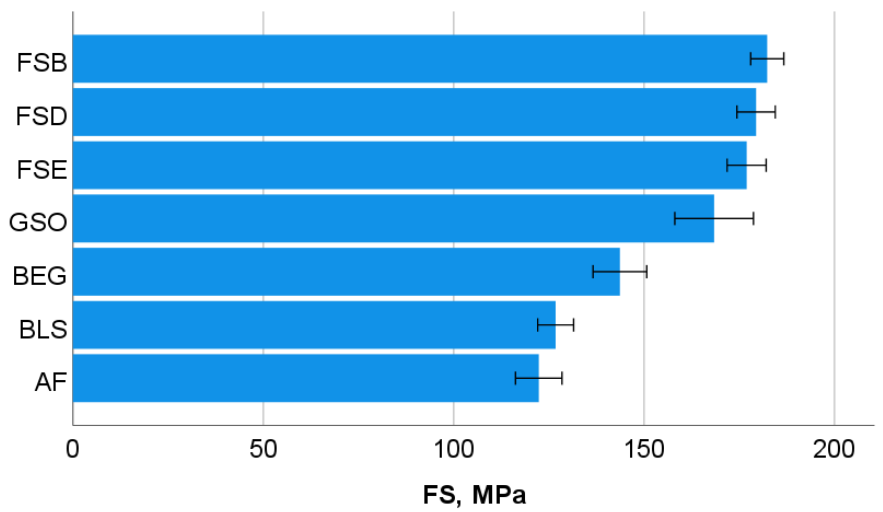
Figure 2. Three-point bending test: flexural strength (FS) with mean values and 95% confidence interval. Material abbreviation: AF = Admira Fusion; BEG = Brilliant EverGlow; BLS = Beautifil II LS; FSB = Filtek Supreme XTE Body; FSD = Filtek Supreme XTE Dentin; FSE = Filtek Supreme XTE Enamel; GSO = Grandio SO.